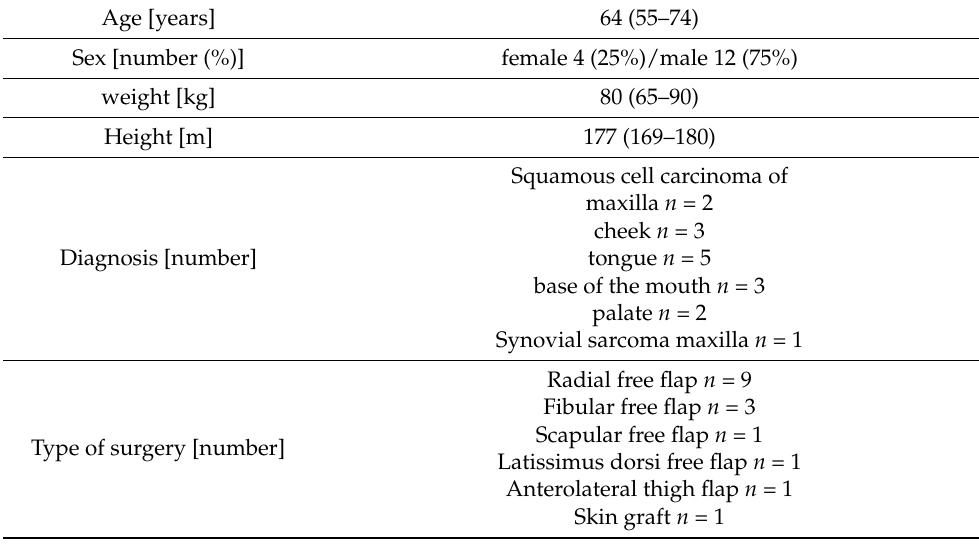
Table 1. Demographic and basic clinical data of patients. Unless otherwise stated, data are presented as median (interquartile range).